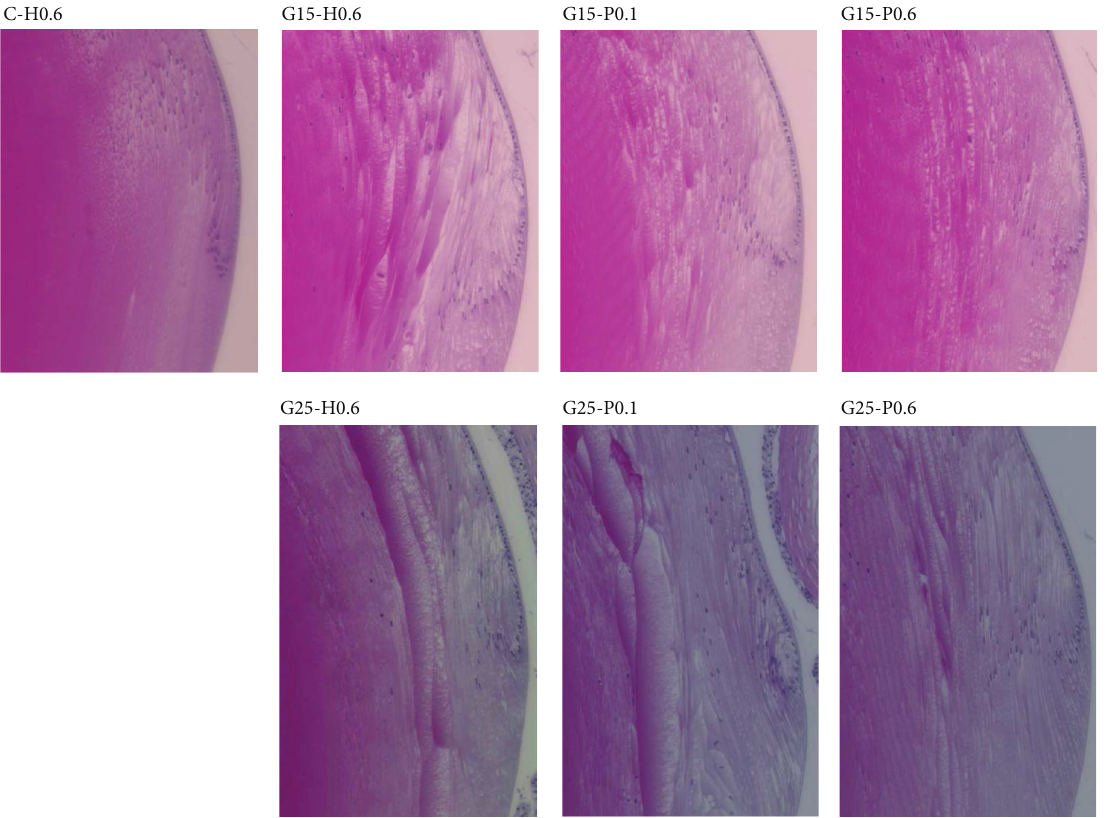
Figure 3: Histological images of sugar cataract formation in rats fed diets containing 15% and 25% galactose with/without propolis treatment. Rats fed a normal diet plus 0.6 g/kg/day honey showed no cataractous changes ((a) and (b)). Three weeks after feeding with 15% galactose plus 0.6 g/kg/day honey, lens fiber swelling was observed in the anterior and equatorial regions, whereas feeding with 25% galactose plus 0.6 g/kg/day honey resulted in marked swelling and liquefaction of the cortical fibers in the equatorial region of the lenses. These histological changes were suppressed by treatment with 0.6 g/kg/day